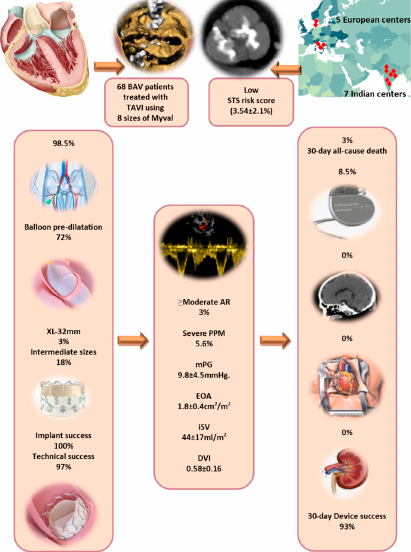
Figure 1. Visual abstract of the Myval bicuspid registry summarizing the key findings of the registry; including the procedural details and outcome, 30-day echocardiographic and clinical outcomes.